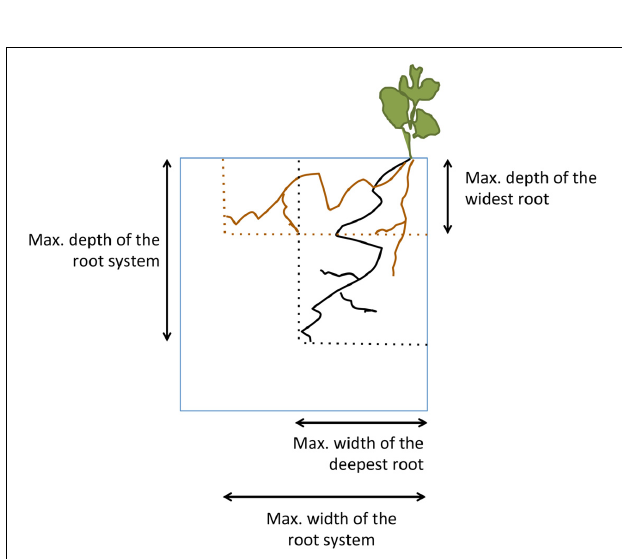
FIGURE 2 | Schematic representation of the plant measurements taken. See section “Materials and Methods” for details.